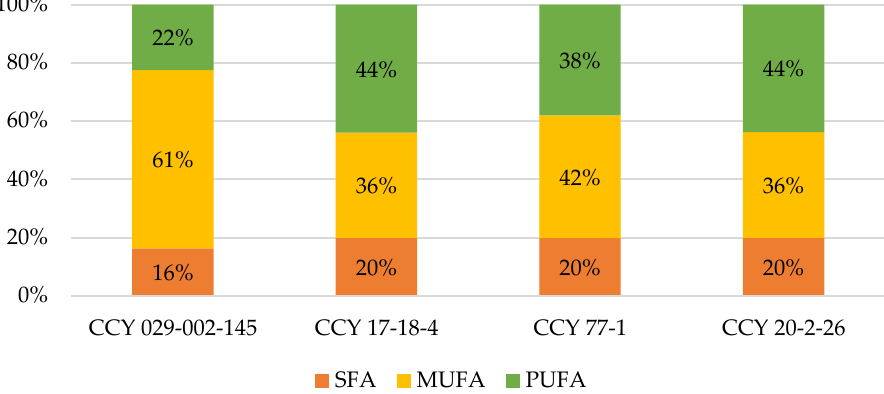
Figure 2. Production of fatty acids by studied pigmented yeasts.